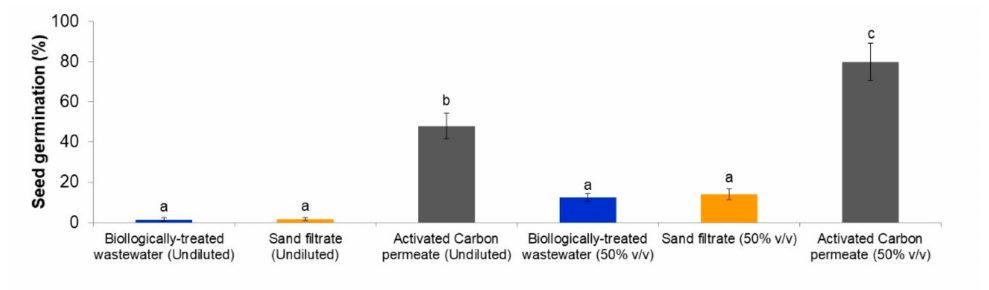
Figure 6. The germination index (GI) values of the biologically treated fungicide-containing effluent, either undiluted or diluted by 50%, before and after treatment through the sand filter and the activated carbon adsorption column system. Bars designated by the same letter are not statistically different at the 5%